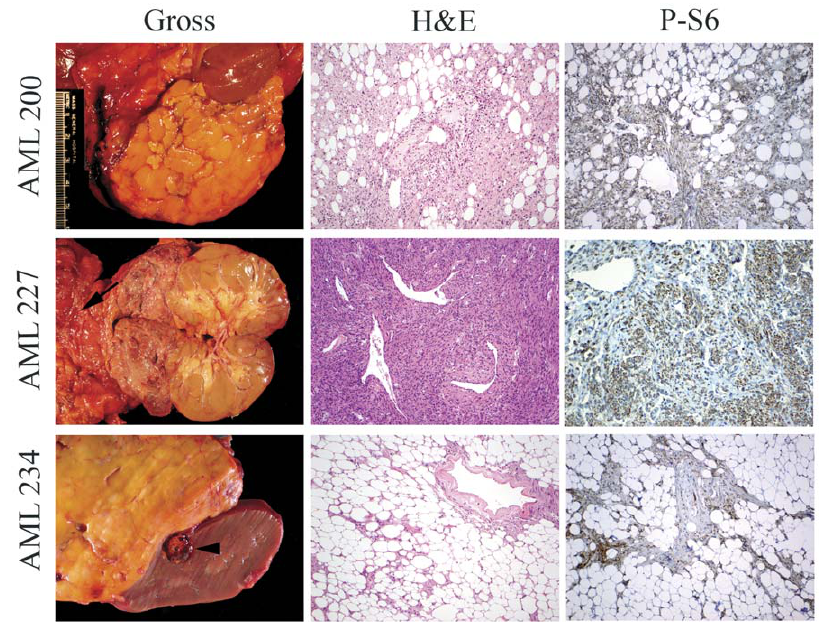
Figure 1. Angiomyolipomas. Gross pictures, micrographs of H&E stains, and immunohistochemical stains with anti-phospho-S6 (S235/S236, P-S6) of AML200, AML227 and AML234 are shown. AML227 arose in the lower pole of the kidney and extended to the attached colon (arrow). AML234 arose adjacent to the kidney. A small renal cell carcinoma is present in the kidney parenchyma (arrowhead).